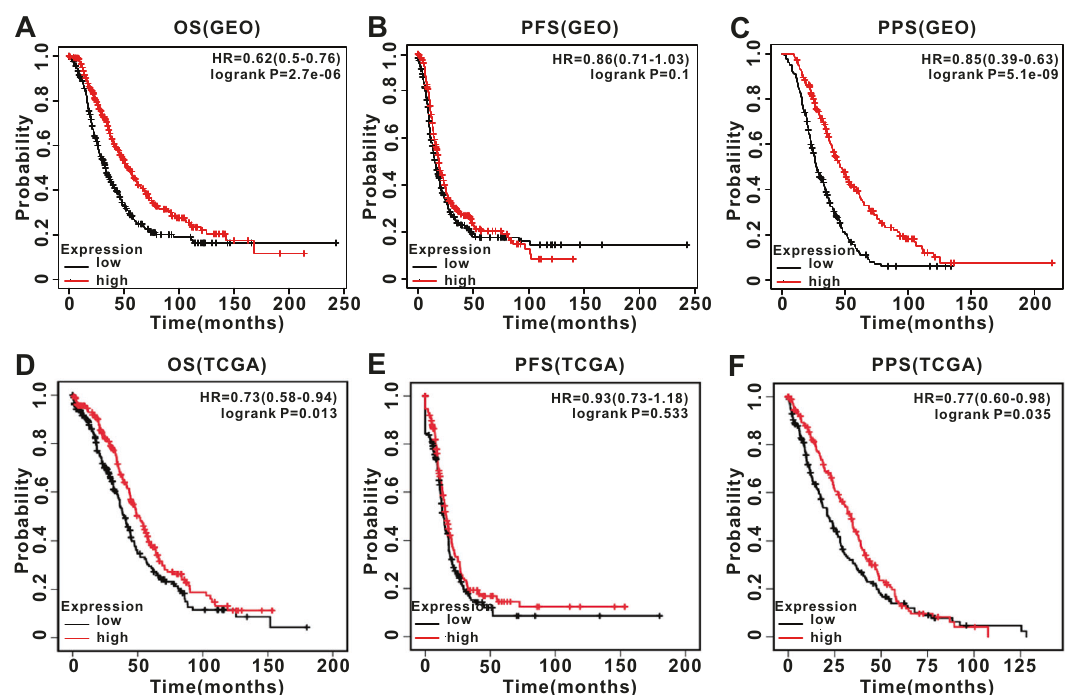
Fig. 6 RNF157-AS1 overexpression indicated a favorable prognosis for EOC patients based on GEO and TCGA databases. According Kaplan – Meier Plotter , EOC patients in the GEO database (including GSE18520, GSE19829, GSE26193, GSE27651, GSE30161, GSE63885, and GSE9891) with high expression of RNF157-AS1 had a good prognosis for OS ( A ) and PPS ( C ) prognoses, but not a good for PFS prognosis ( B ) compared with those patients with low expression of RNF157-AS1. Based on TCGA database analysis, EOC patients with high RNF157-AS1 exhibited increased OS ( D ) and PPS ( F ) time compared with patients with low levels of RNF157-AS1 expression. However, RNF157-AS1 expression had no effect on the PFS ( E )